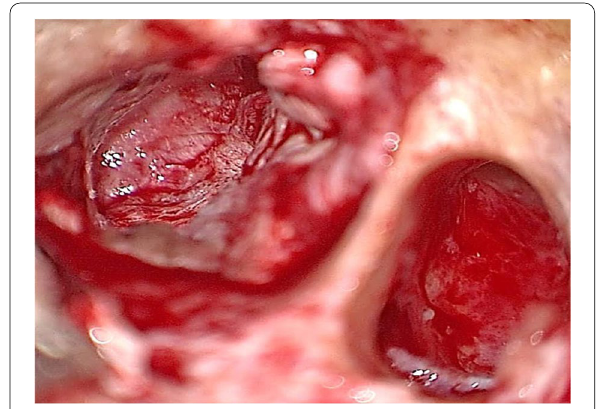
Fig. 4 Temporalis fascia graft placed by the underlay technique